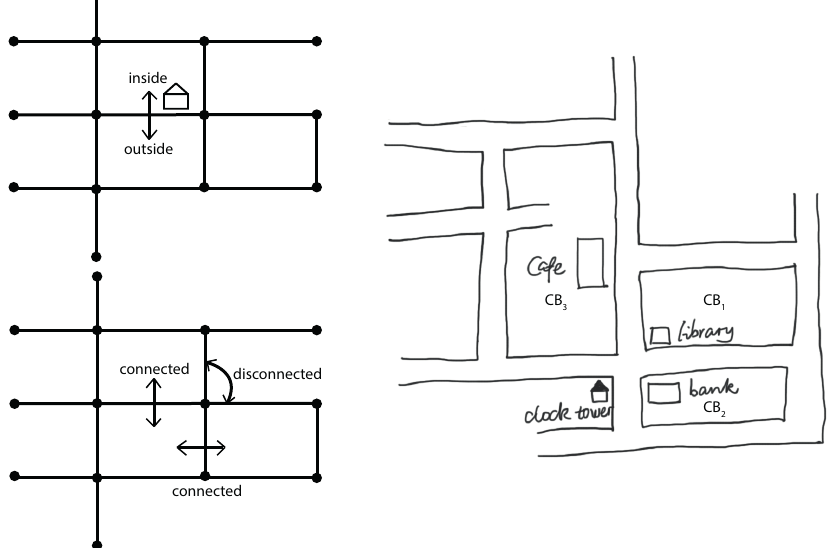
Figure 7: Definition (left) and an example of measuring topological relations of landmarks and city blocks